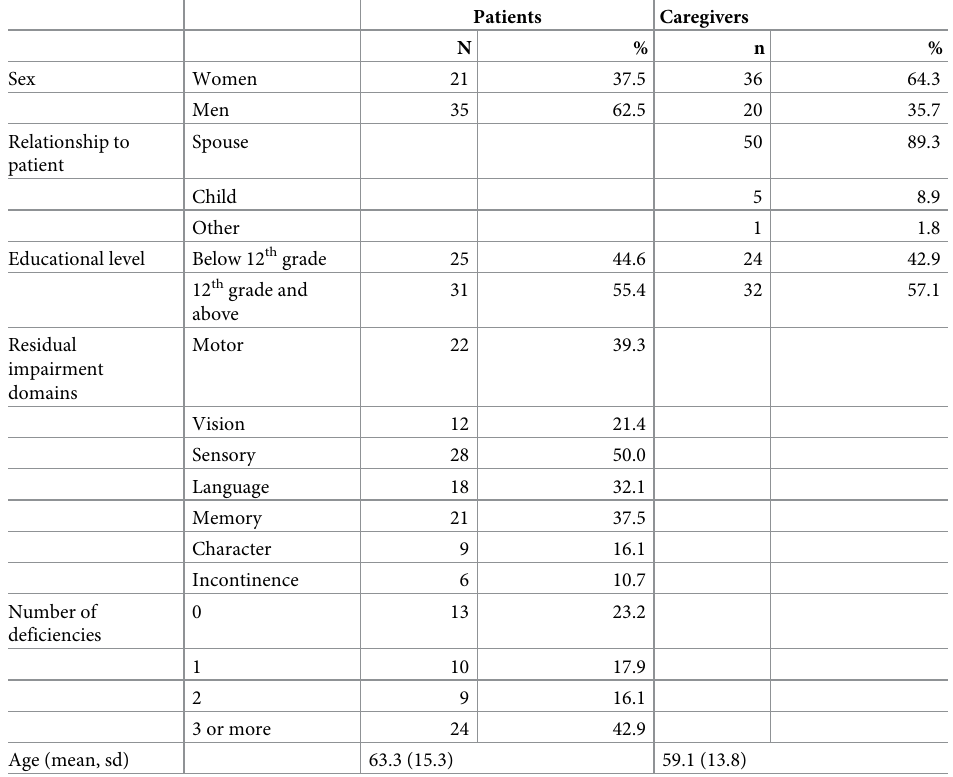
Table 1. Socio-demographic and health characteristics of the 56 dyad